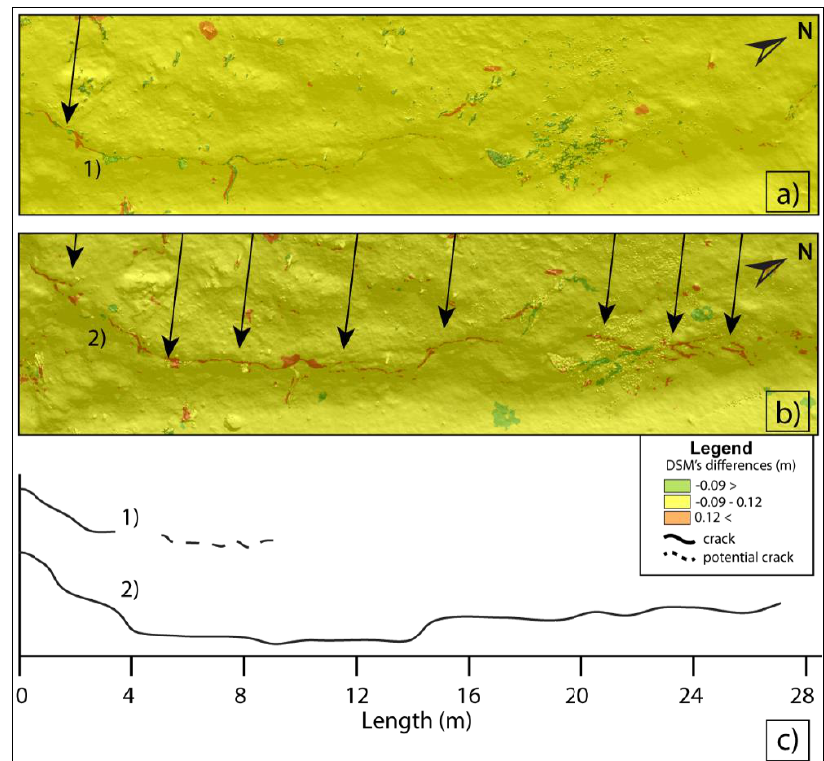
Figure 7. The gradual expansion of the crack in Kechries site one is visible in the central part of the slope, towards the northeast, as is described in ( a ) the differences between the August 2020 and the October 2020 UAV – derived DSM (crack 1), as well as its possible continuation (dashed line) and ( b ) the differences between the October 2020 and the March 2021 UAV – derived DSM (crack 2). It is clear that the described crack ( c ) has significantly expanded from approximately 4 m to approximately 27.5 m. Black arrows indicate possible cracks in the soil surface.